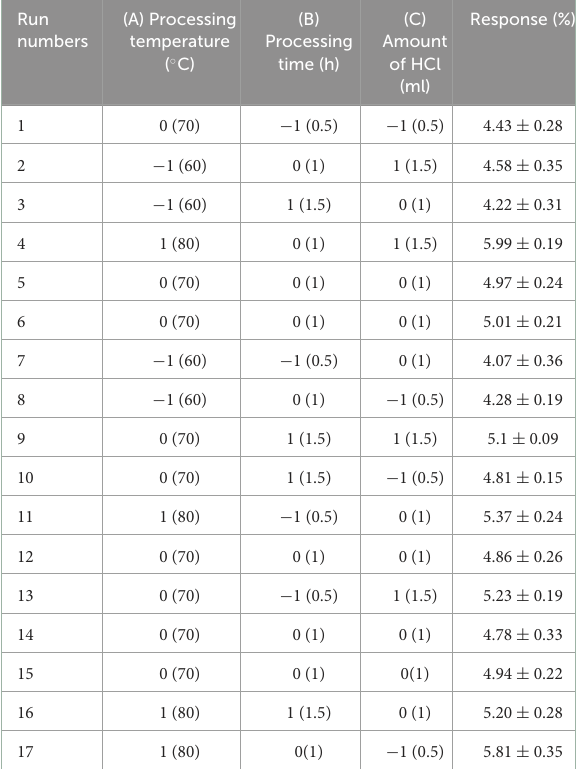
TABLE 1A The Box-Behnken design matrix and the results for extraction yield of crude polysaccharides from Sanghuangporus vaninii